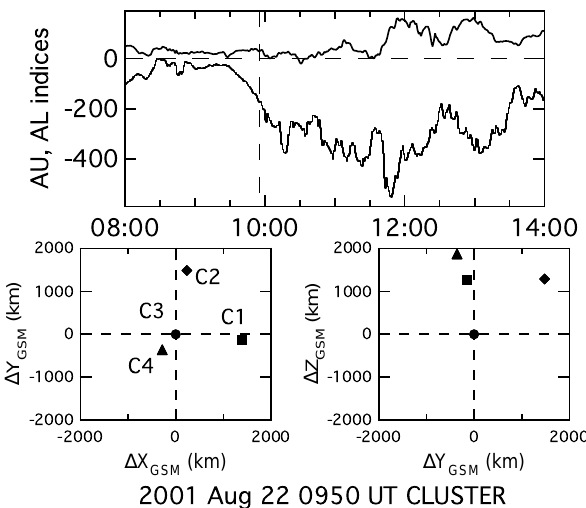
Fig. 1. The AU (upper) and AL (lower) indices on 22 August 2001 and the relative positions of four Cluster satellites in the XY- and YZ-planes in GSM